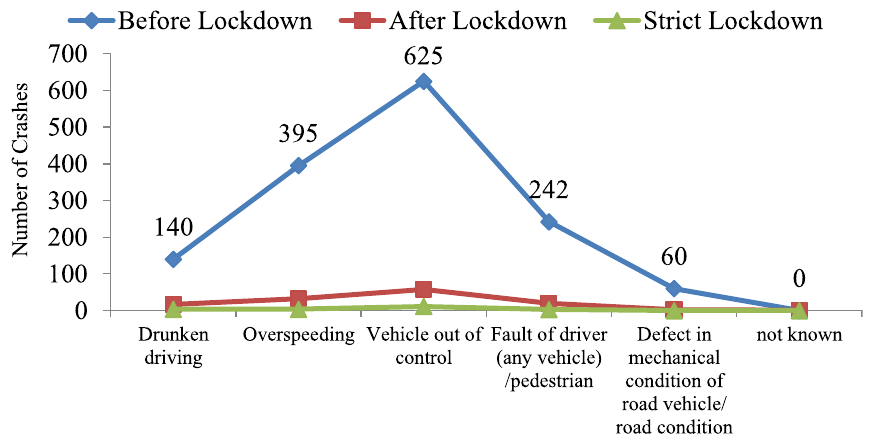
Fig. 4 Analysis of crash data by causes of crash